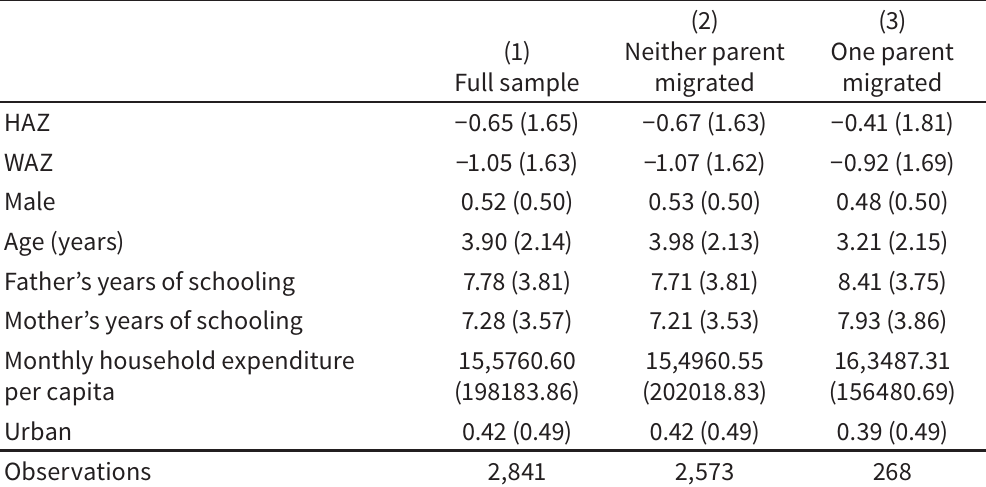
Characteristics of children by migration status of parents (year 2000)